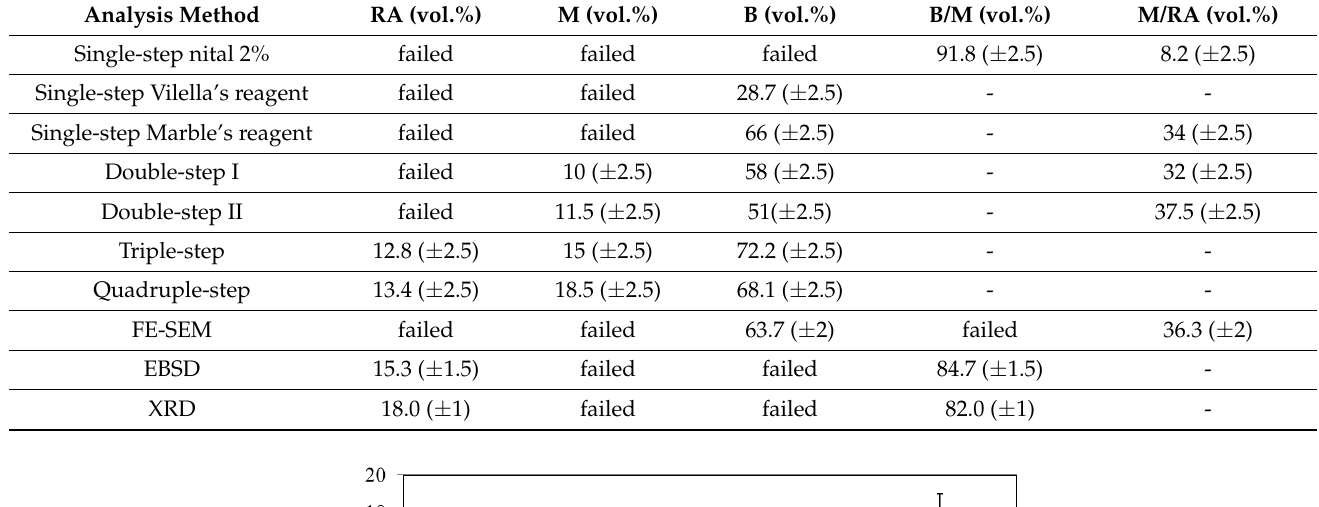
Table 4. Various phase constituents detected and estimated using different techniques.